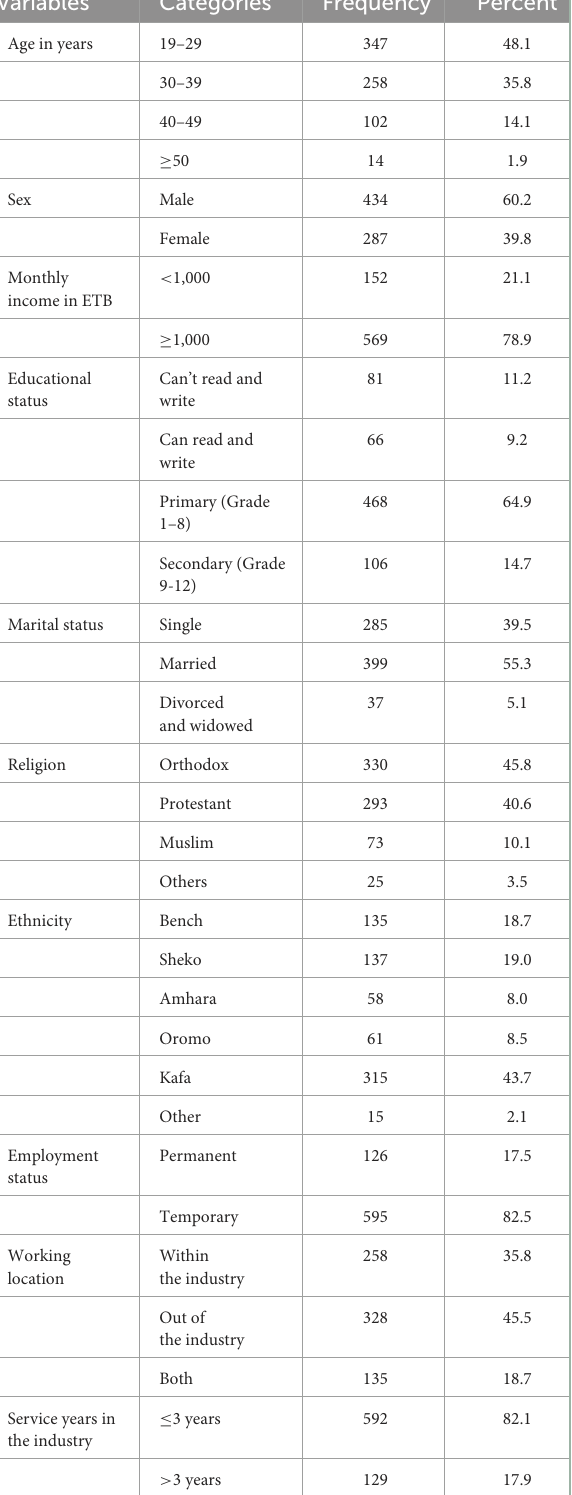
TABLE 1 Socio-demographic and other general characteristics of the respondents, May/2021, Bench-Sheko and Kafa Zone.